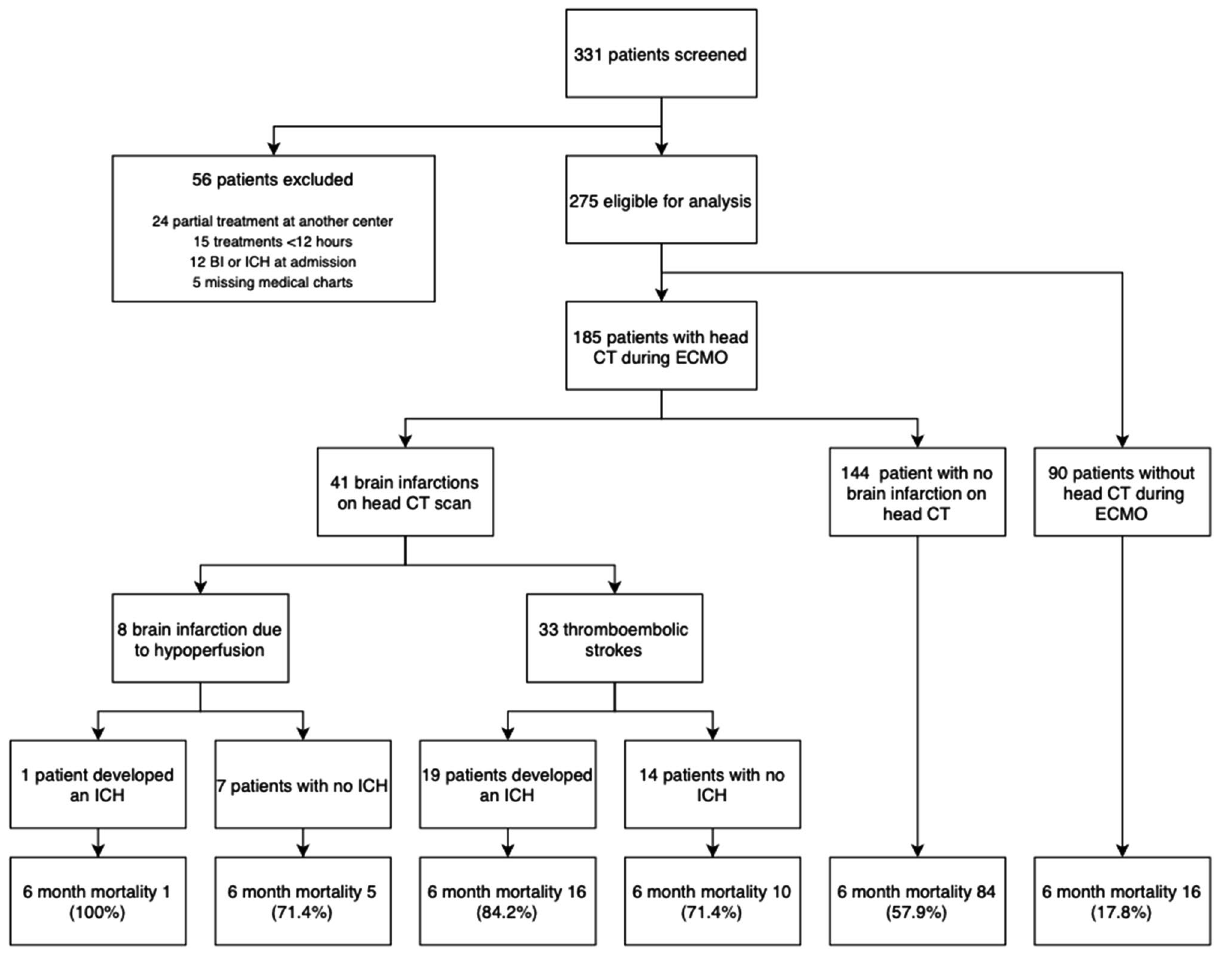
Figure 1. Schematic overview of patient inclusion and outcome. BI brain infarction, ICH intracerebral hemorrhage, ECMO extracorporeal membrane